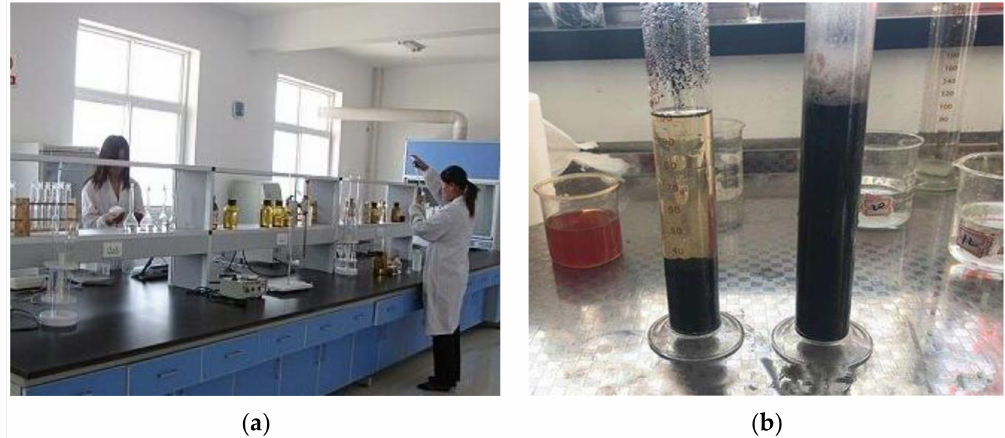
Figure 5. Laboratory testing of coal mine water quality. ( a ) Sample preparation; ( b ) after